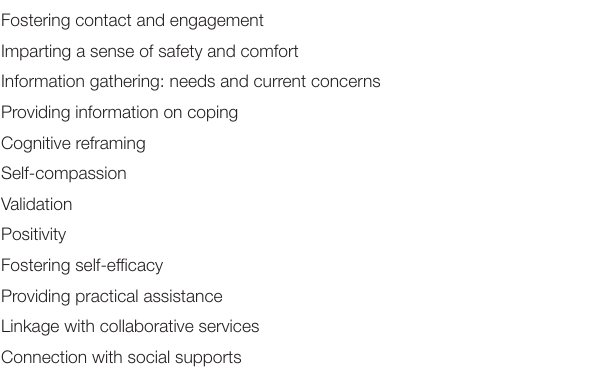
TABLE 3 | List of psychological interventions used during the study. Fostering contact and engagement Imparting a sense of safety and comfort Information gathering: needs and current